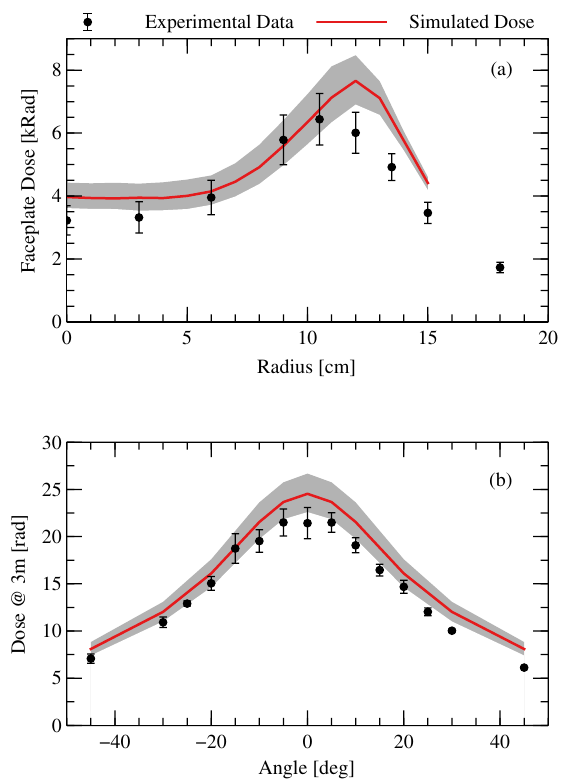
FIG. 5. Comparison of measured (black) and simulated (red) dose from the Case 0 simulations, in (a) the near field and (b) the far field. The mean of the experimental data is shown as circles, and the standard deviation is shown by the error bars. The gray uncertainty bounds on the simulated dose are computed from the simulations driven by the measured outer current (cid:2) the